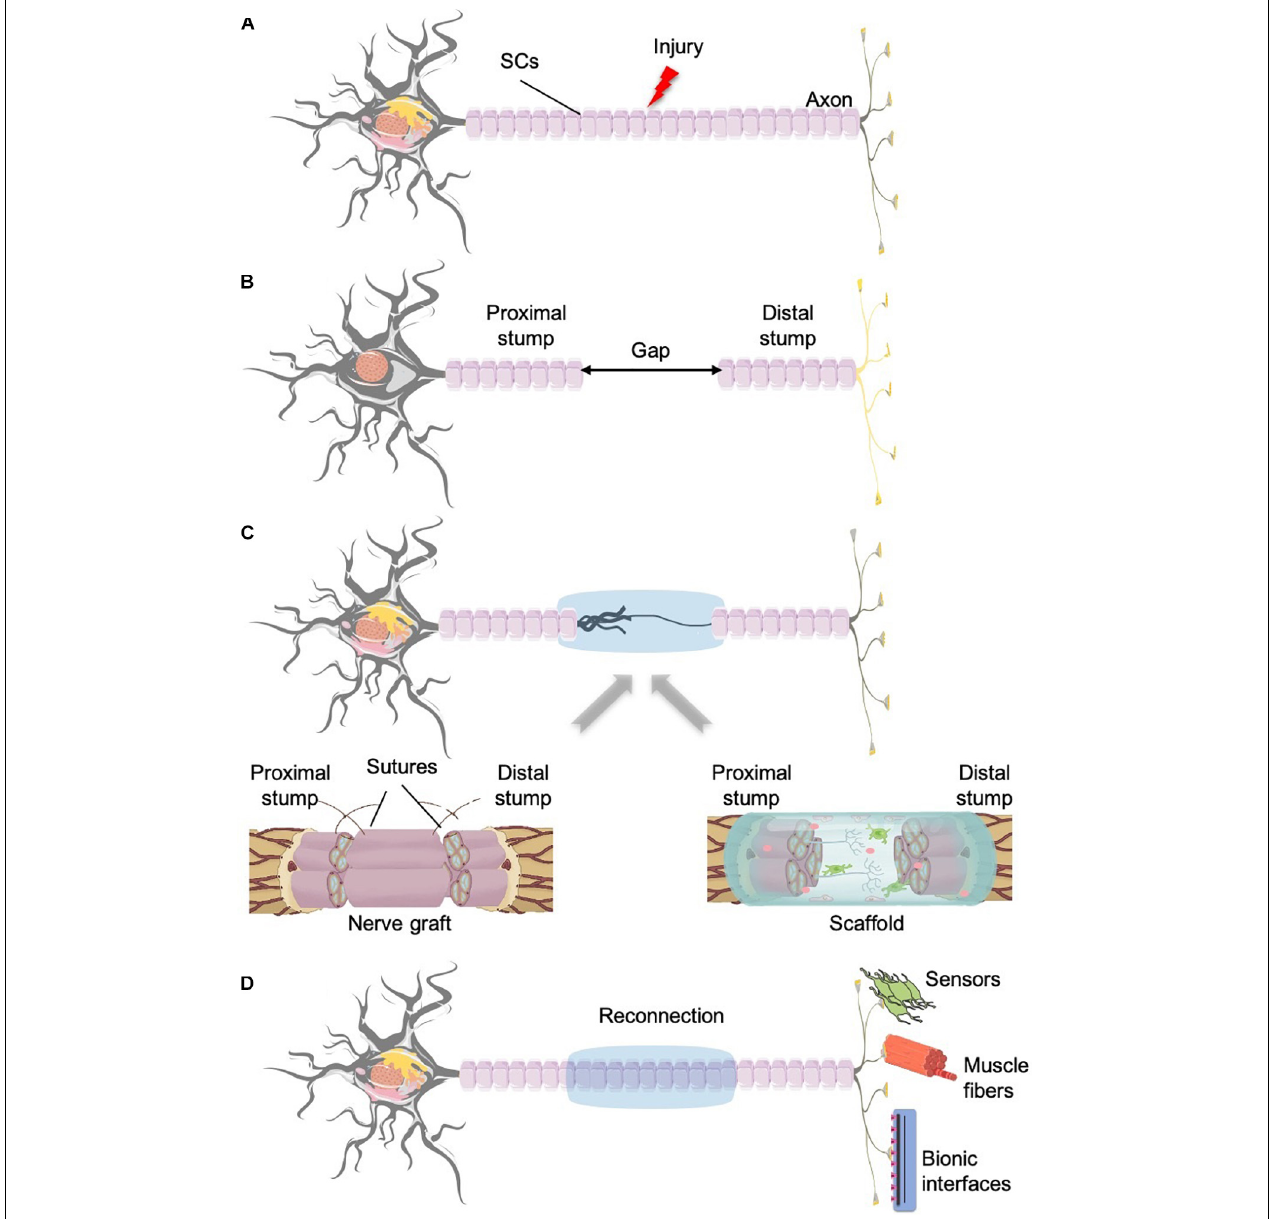
FIGURE 3 | Nerve injury and regeneration with the aid of grafts or biomaterials scaffolds. (A) Neuron divided into proximal stump and distal part that innervates the target tissue. (B) After the damage takes place, the gap created between the two parts provokes that the regeneration cannot take place properly because of the lack of communication between the two stumps. (C) Different approaches to obtain the connection of the two stumps and the guidance of the growing axons: left, nerve graft; right, biomaterials and tissue engineering. (D) Once the reconnection of the two ends of the injured nerve is achieved, these neurons will be able to reinnervate the former target tissue, divided into sensors and muscles; or in the case that the target tissue has been lost, the reconnection with bionic